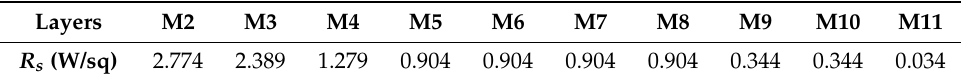
Table 1. Sheet resistance ( R s ) in 7 nm node technology.